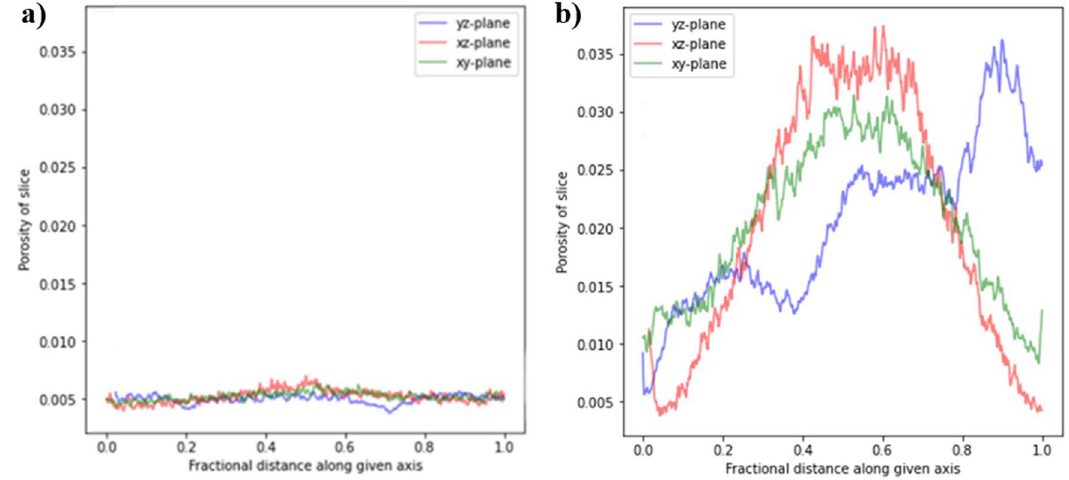
Figure 19. While analyzing pore arrangement before acidification, pore conduct was uniform. ( a ) Before degradation and ( b ) after